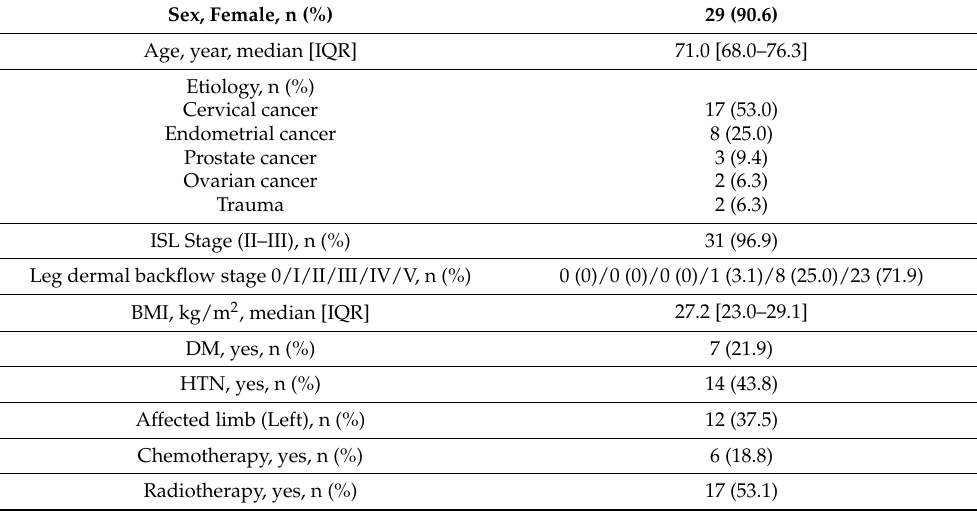
Table 1. Demographics for older patients (n =